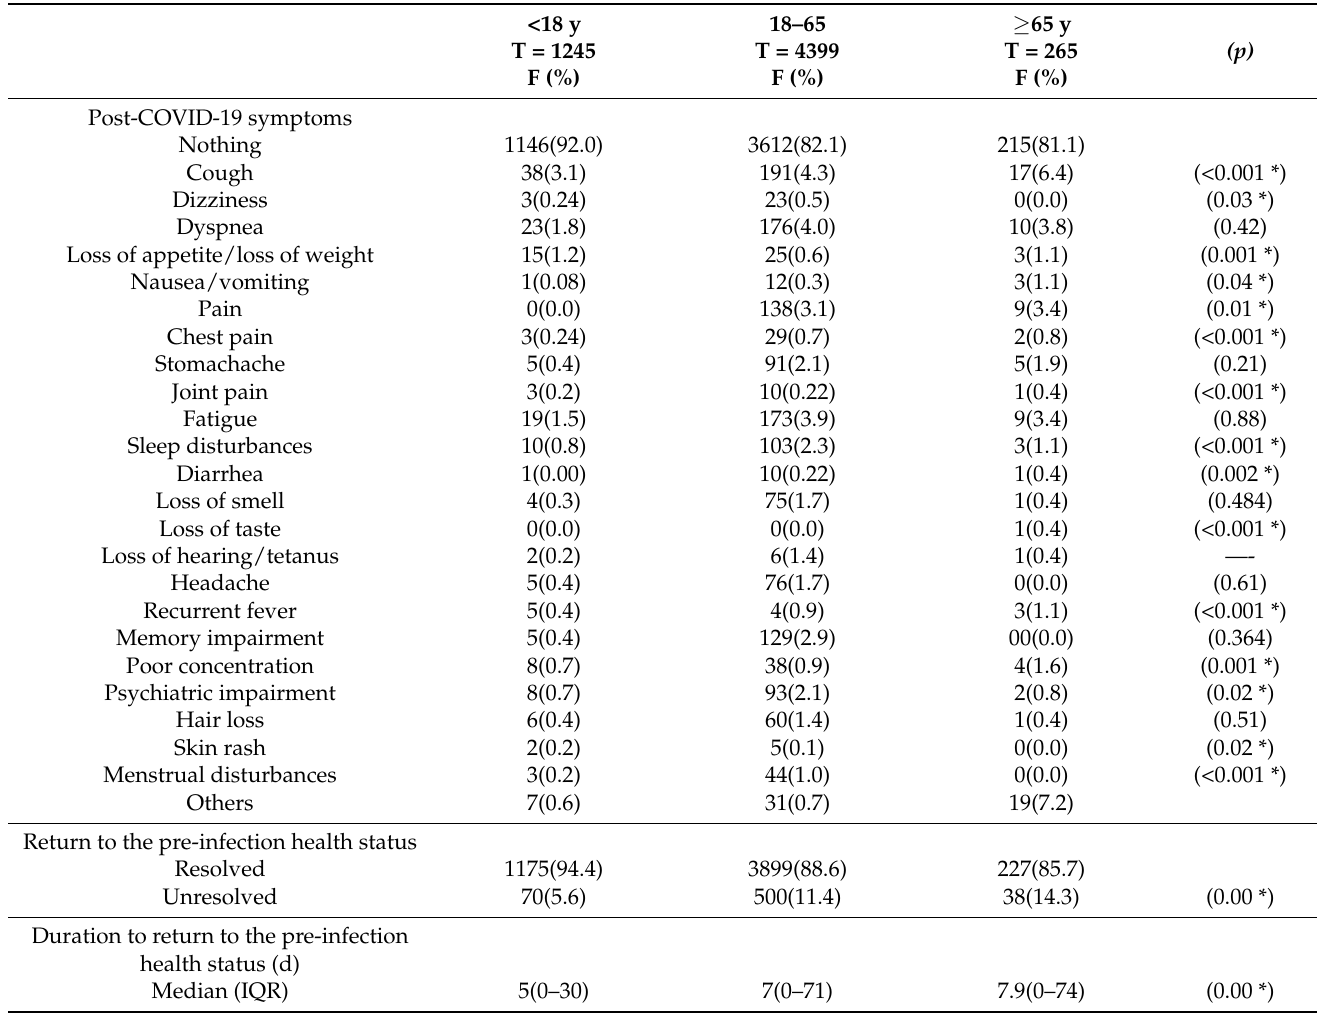
Table 3. Self-reported post-COVID-19 symptoms among different age